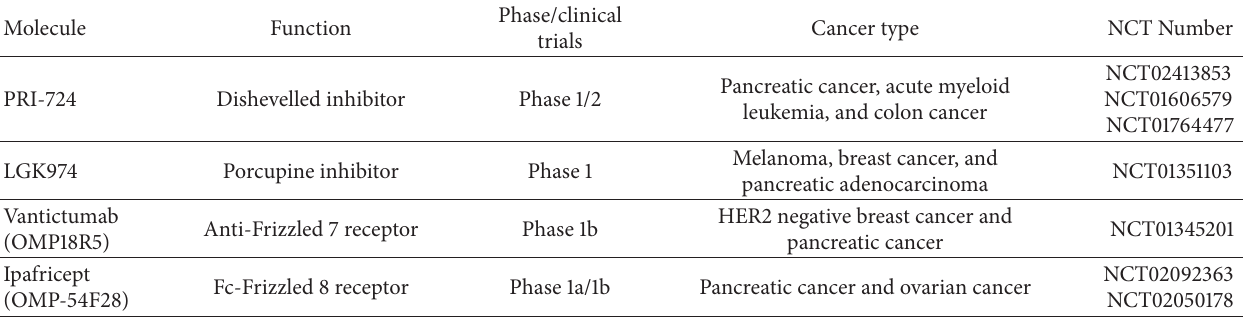
Table 1: Small molecule/biological therapeutics targeting the Wnt